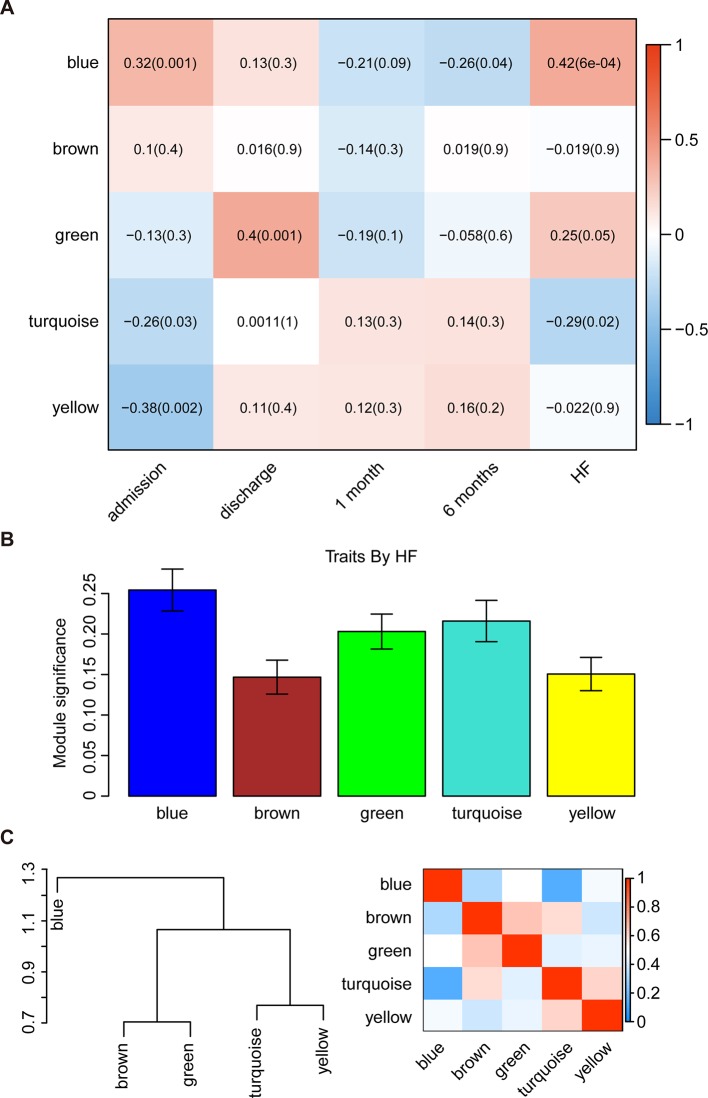
Identification of the key modules associated with the development of HF after AMI. (A) Heatmap depicting the correlation between module eigengenes and clinical traits of AMI. (B) Distribution of module significance and errors in the modules associated with the development of HF after AMI. (C) Hierarchical clustering dendrogram showing the module eigengenes and a heatmap of the adjacencies in the eigengene network (labeled according to by their module color names).